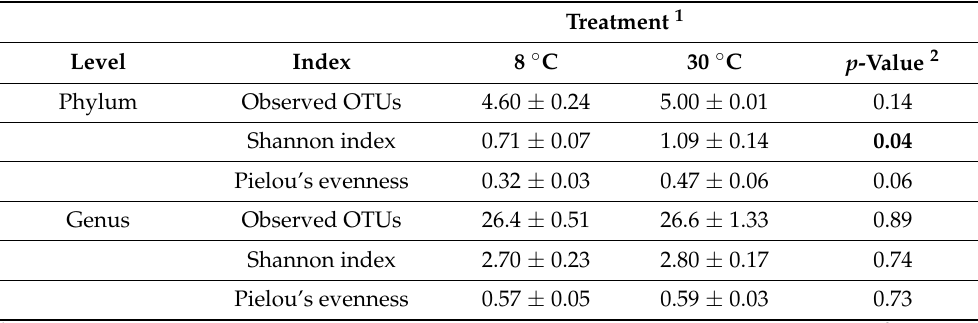
Table 2. Alpha diversity indices at the phylum and genus levels from the cecum of mice exposed to different temperatures.